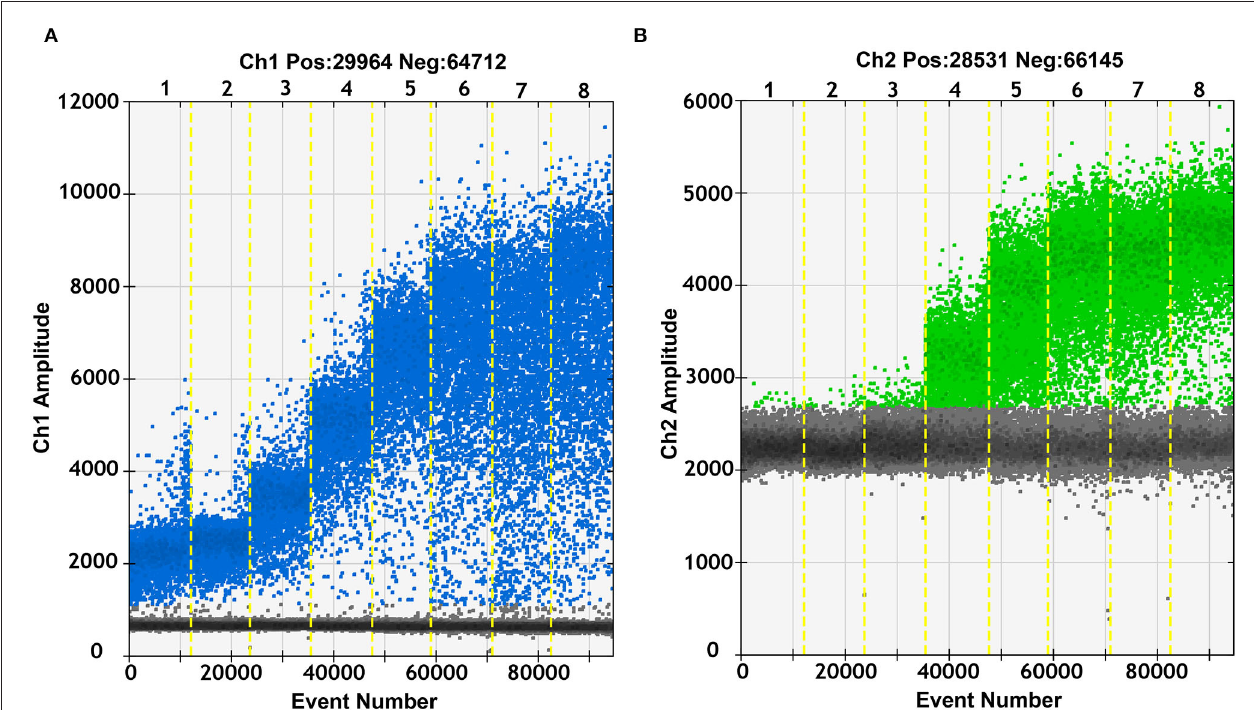
FIGURE 1 | Annealing temperature optimization of duplex droplet digital polymerase chain reaction (ddPCR) assay. The duplex ddPCR assay for pB646L (A) and pEP402R (B) was optimized with different annealing temperatures and the fluorescence amplitude of amplification determined the optimal reaction condition.